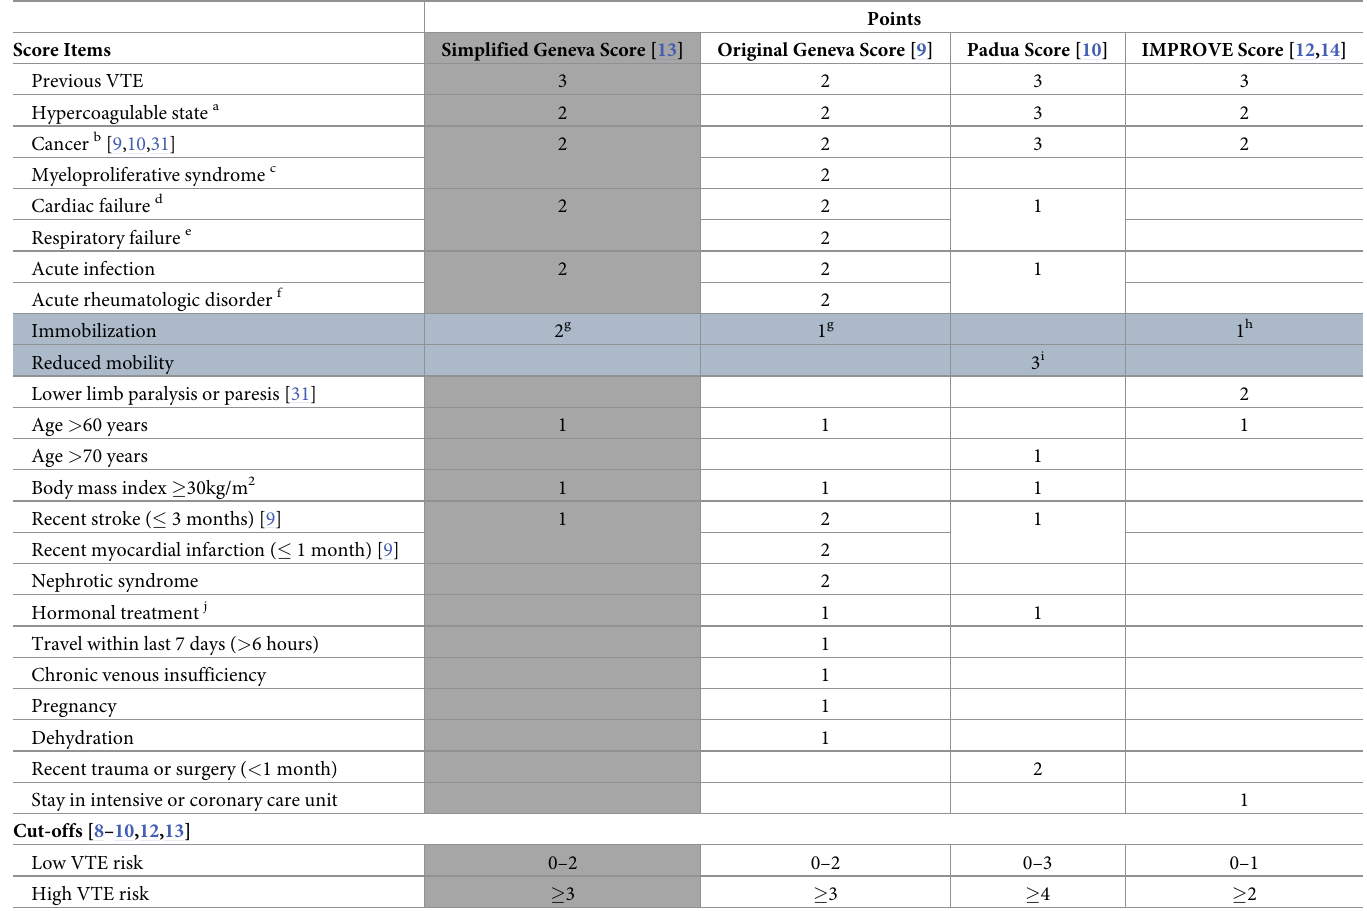
Table 2. VTE risk assessment models for risk stratification in hospitalized medical